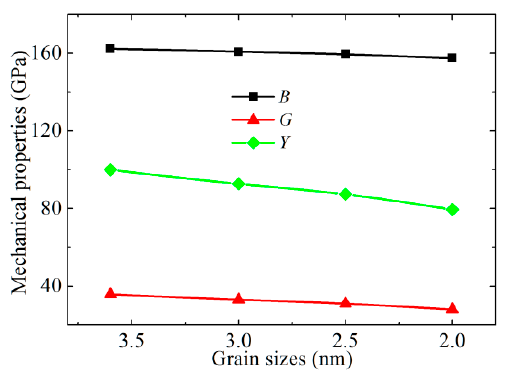
Figure 2. The bulk, shear, and Young’s modulus properties of CoCrFeNiMn with different mean grain sizes.